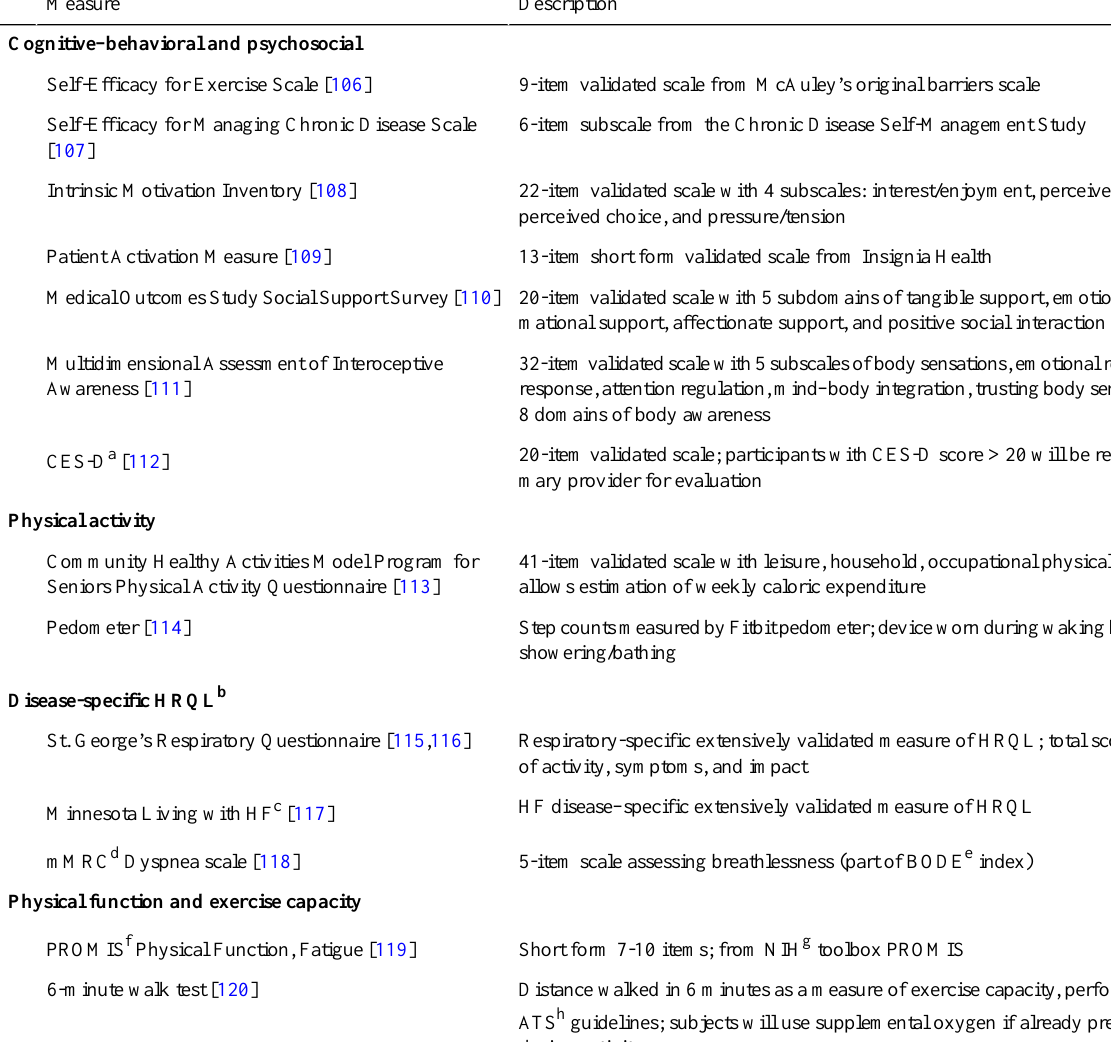
Table 3. Patient-centered